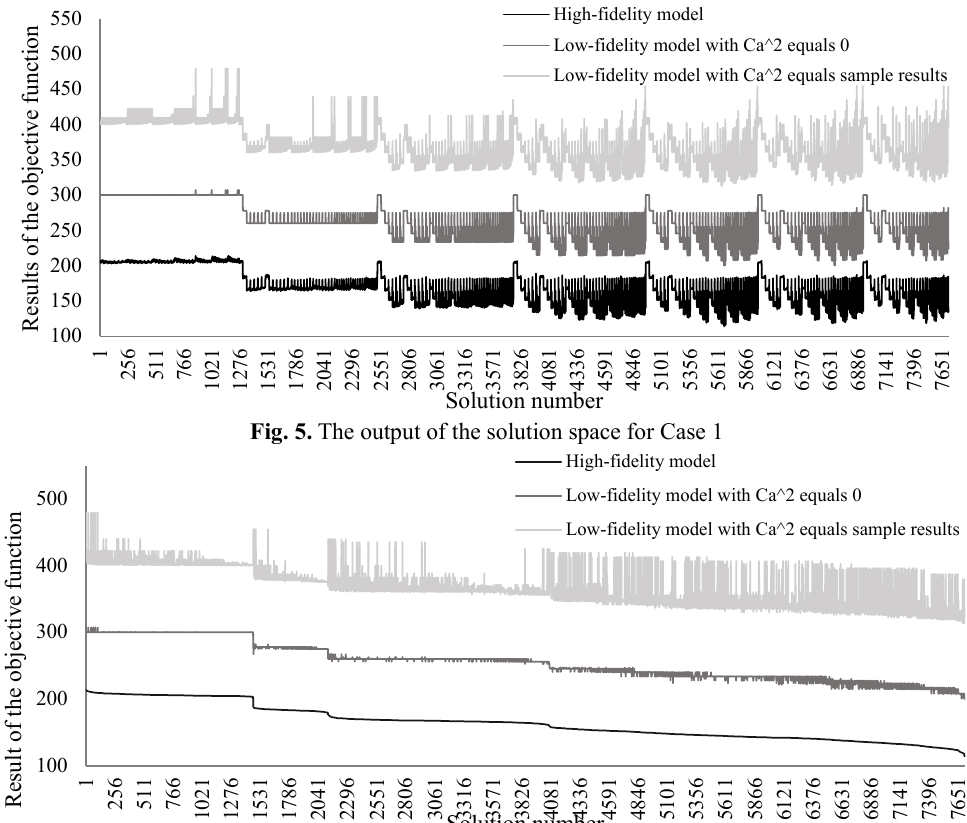
Fig. 5. The output of the solution space for Case 1